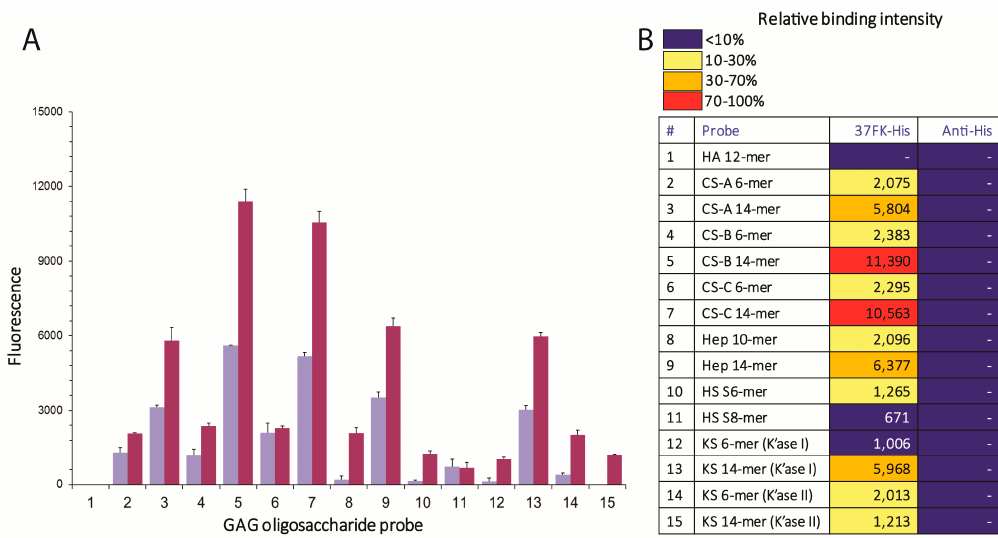
Figure 1. Glycan microarray analysis of HAdV-D37 fiber knob interaction with glycosaminoglycan (GAG) oligosaccharides showing selective binding to sulfated GAG oligosaccharides. ( A ) Histogram chart showing fluorescence intensities of binding of His-tagged HAdV-D37 fiber knobs as means of duplicate spots at 2 fmol/spot (purple) and 5 fmol/spot (red). Error bars represent half of the difference between the two values. ( B ) Heat map of relative intensities and fluorescence binding scores of HAdV-D37 fiber knob (means of duplicate spots at 5 fmol/spot). No binding was detected with the detection antibodies in the absence of His-tagged HAdV-D37 fiber knob. The probe list with sequences of GAG oligosaccharides is in Table S1.